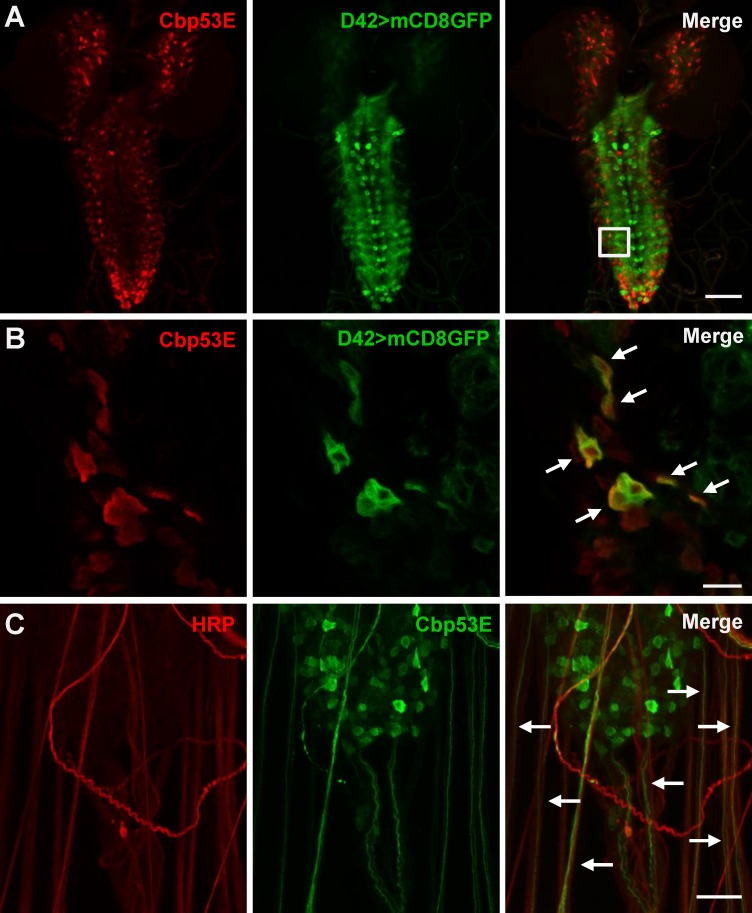
Expression of Cbp53E in the larval brain.A) Representative maximum intensity projection of a third instar larval brain from animals expressing UAS-mCD8GFP (green) from a D42-GAL4 motor neuron specific driver. Anti-Cbp53E staining (red) shows discrete expression patterns. Scale bar is 50μm. B) A single slice from the magnified region outlined in the merge panel in (A). Significant colocalization of anti-Cbp53E (red) and GFP (green) is seen in many cells (arrows). Scale bar is 10μm. C) Strong Cbp53E expression (green) can be seen in nerve fibers labeled with anti-HRP (red) as they exit the larval central nervous system (arrows). Scale bar is 20μm.